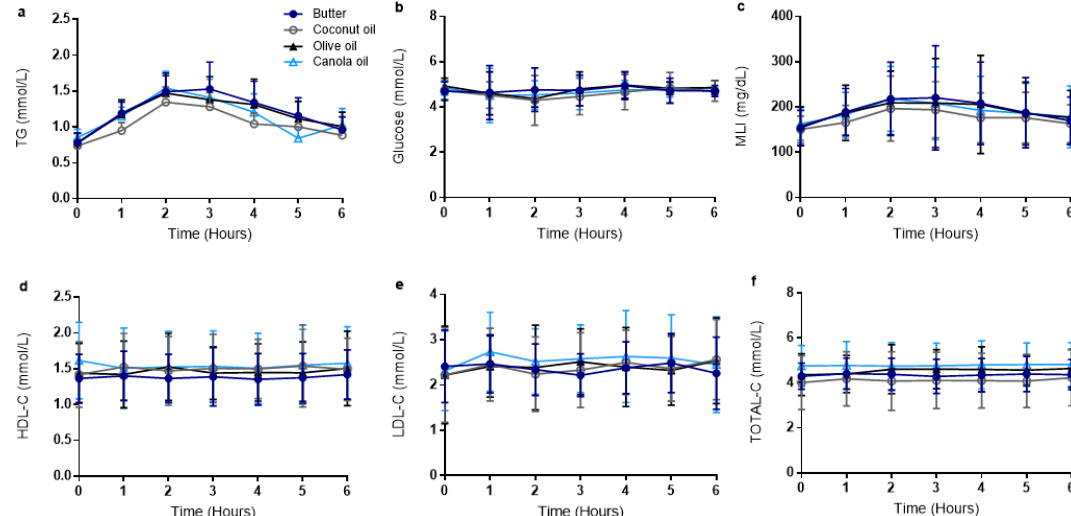
Figure 2. Postprandial metabolic responses. Metabolic responses in the four meal trials at baseline and hourly throughout the postprandial period for ( a ) TG, ( b ) glucose, ( c ) MLI, ( d ) HDL-C, ( e ) LDL-C, and ( f ) TOTAL-C. Data are presented as mean ± SD. Closed circles indicate B meal trial, open circles indicate CoO meal trial, closed triangles indicate OO meal trial, and open triangles indicate CaO meal trial. Error bars indicate SD. TG, triglycerides; MLI, metabolic load index; HDL-C, high-density lipoprotein cholesterol; LDL-C, low-density lipoprotein; TOTAL-C, total cholesterol; B, butter; CoO, coconut oil; OO, olive oil; CaO, canola oil.